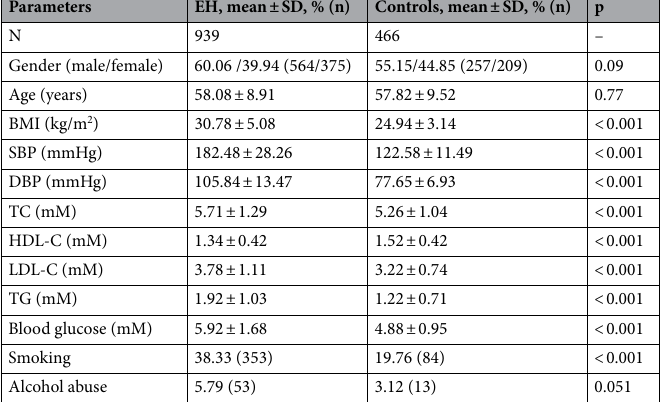
Table 1. Phenotypic characteristics of the study participants. Clinical characteristics of age, BMI, SBP, DBP, HDL-C, LDL-C, TG and TC are given as means ± SD and other values as number of individuals. BMI , body mass index, SBP , systolic blood pressure, DBP , diastolic blood pressure; TC , total cholesterol, HDL‑C , high- density lipoprotein cholesterol, TG , triglycerides, LDL‑C , low-density lipoprotein